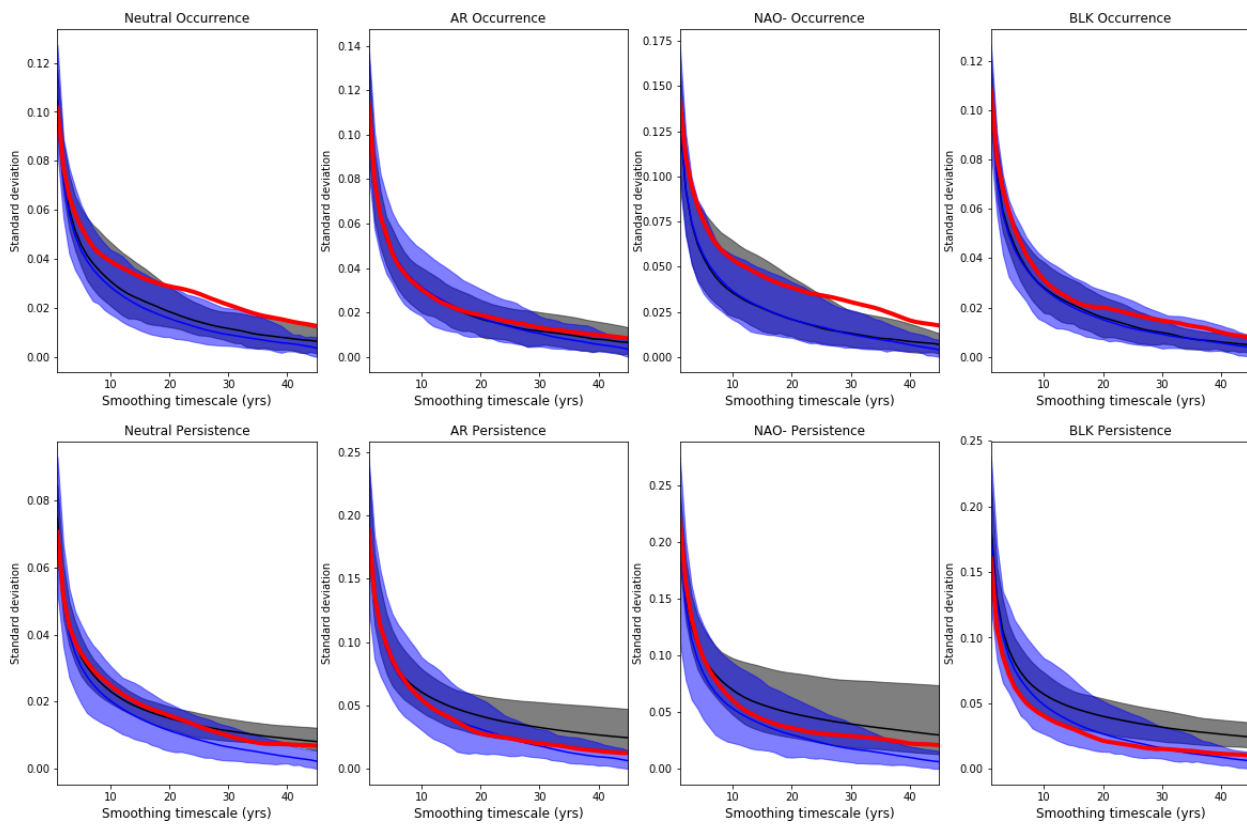
Figure 12. Standard deviation of seasonal regime occurrence and persistence as a function of smoothing timescale, showing the variability of the regime statistics on a range of timescales. Thick lines indicate ensemble means of each model’s standard deviation, while shading shows the model spread. Red, black, and blue lines indicate multi-reanalysis mean, CMIP6, and CMIP5 standard deviations